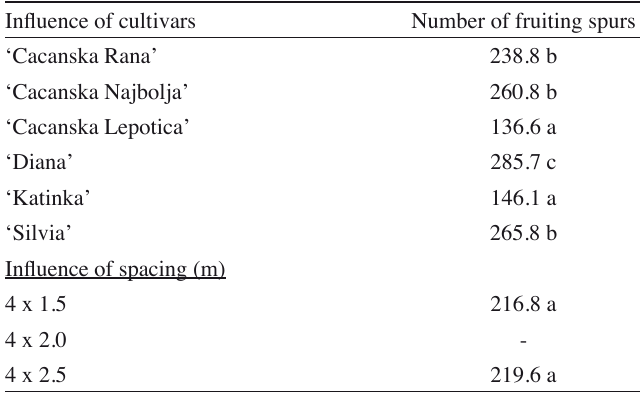
Different letters indicate significant differences separately for cultivars and spacing at P=0.05.